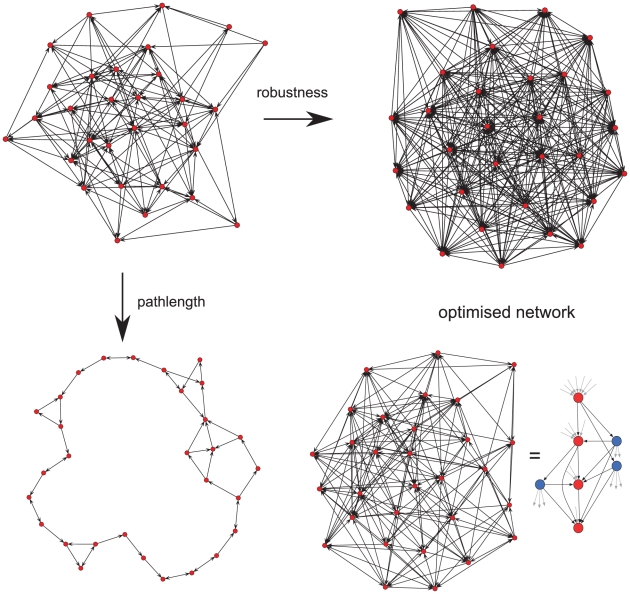
Network optimisation over two evolutionary traits.An initially random network (top left) can be evolved to optimise either
robustness (top right), i.e. the potential for evading immune responses,
resulting in a fully connected network, or path length (bottom left)
which minimised repertoire exposure to the immune system and thus
results in a ring-like structure with minimum connectivity between
nodes. Optimising over both traits simultaneous produces a network
consisting of variants which either switch to many other variants or
being switched to from many other variants (bottom right). The
lattice-like structure is highlighted to the right of the network,
indicating ‘sink’ (red) and ‘source’ nodes
(blue).